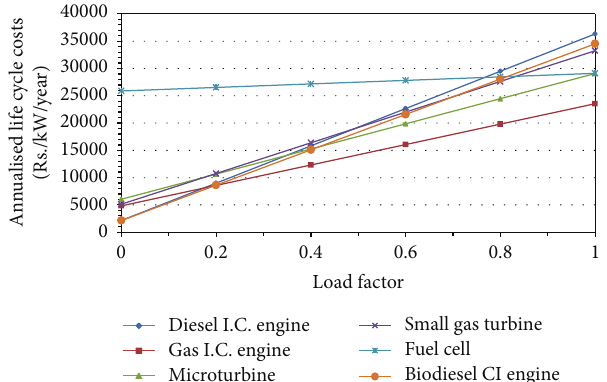
Figure 9: Comparison of annualised life cycle costs for different technological options when DG-CHP is considered (discount rate (𝑑) = 30 %) for the month of January